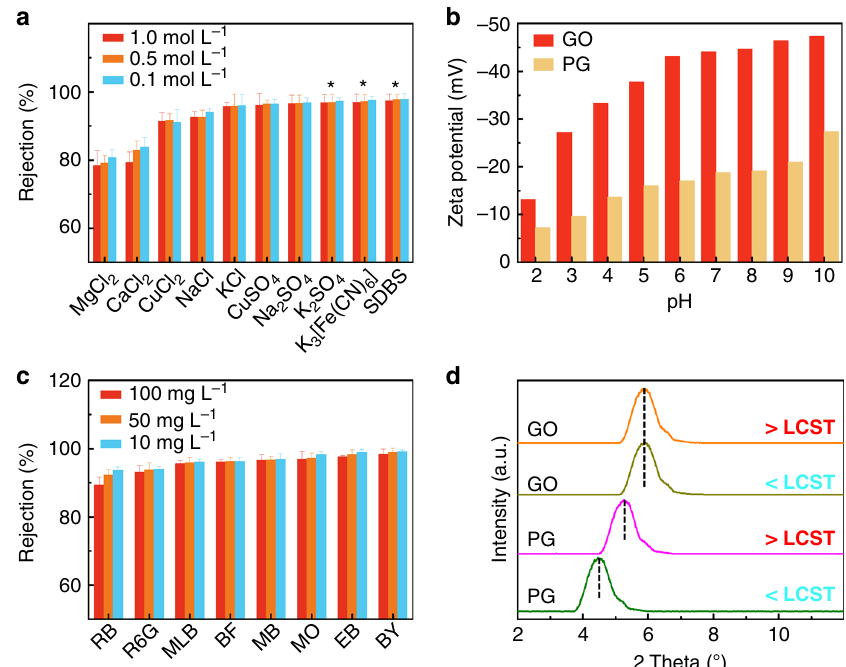
Fig. 5 Performance of PNPG-F for single ion and molecule separation. a Rejection of ions through PNPG-F under sunlight irradiation. The asterisk (*) denotes the concentration of sodium dodecyl benzenesulfonate (SDBS, 0.05, 0.01, and 0.005M), K 3 [Fe(CN) 6 ] (0.1, 0.05, and 0.001M), and K 2 SO 4 (0.1, 0.05, and 0.001M), respectively. b The zeta potentials of graphene oxide (GO) and pure PG dispersion measured in a pH range of 2 – 10. c Rejection of dye molecules through PNPG-F under sunlight irradiation. d X-ray diffraction (XRD) peak showing shifts of the (001) peak due to the shrinking of PNIPAm chains under sunlight irradiation. Error bars denote standard deviations from three samples measured multiple times. Source data are provided as a Source Data fi